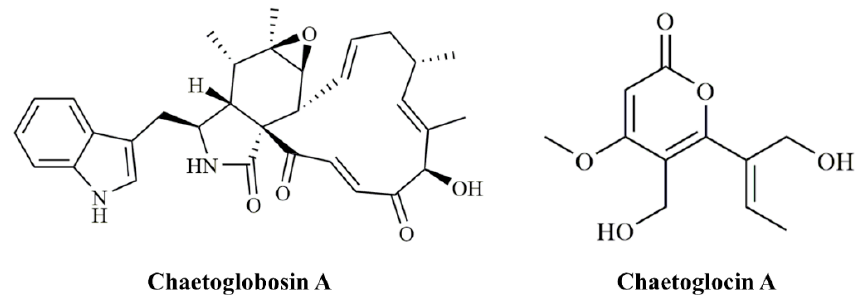
Figure 1. Chemical structures of chaetoglobosin A and chaetoglocin A.